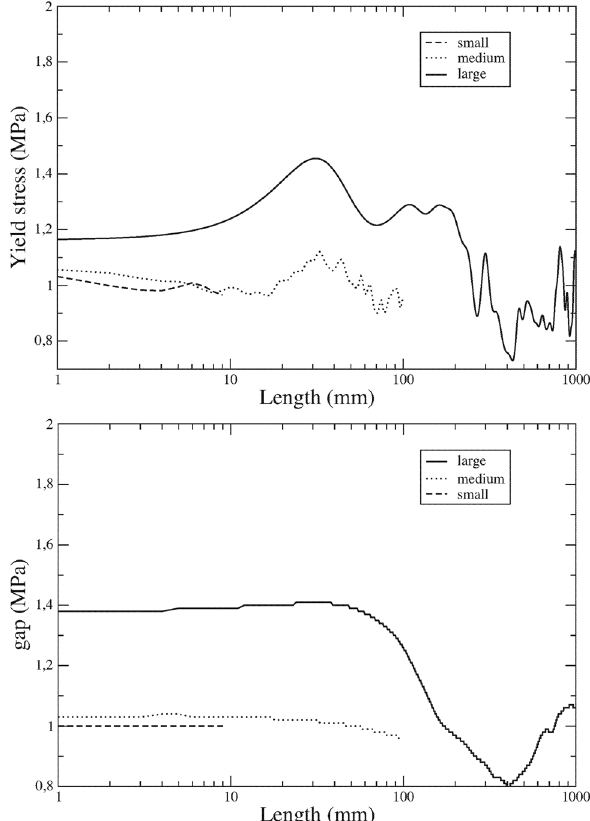
Fig. 24 Normalized realizations of correlated macro random fields 𝜎